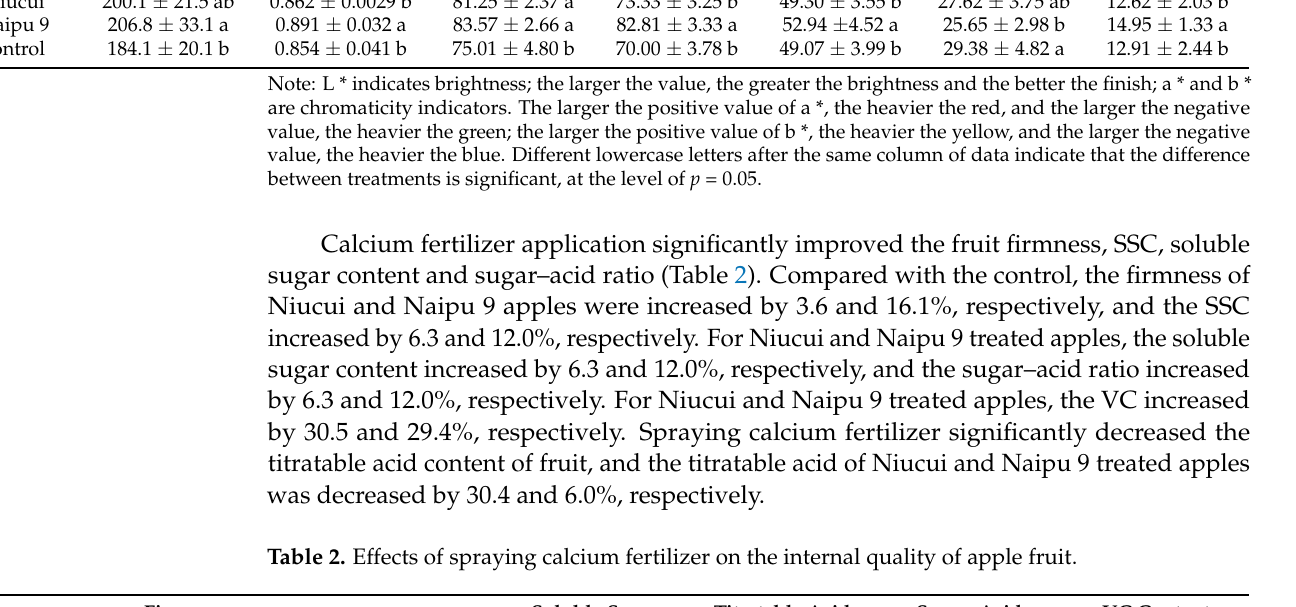
Table 1. Effects of spraying calcium fertilizer on appearance quality of apple fruit. Treatment